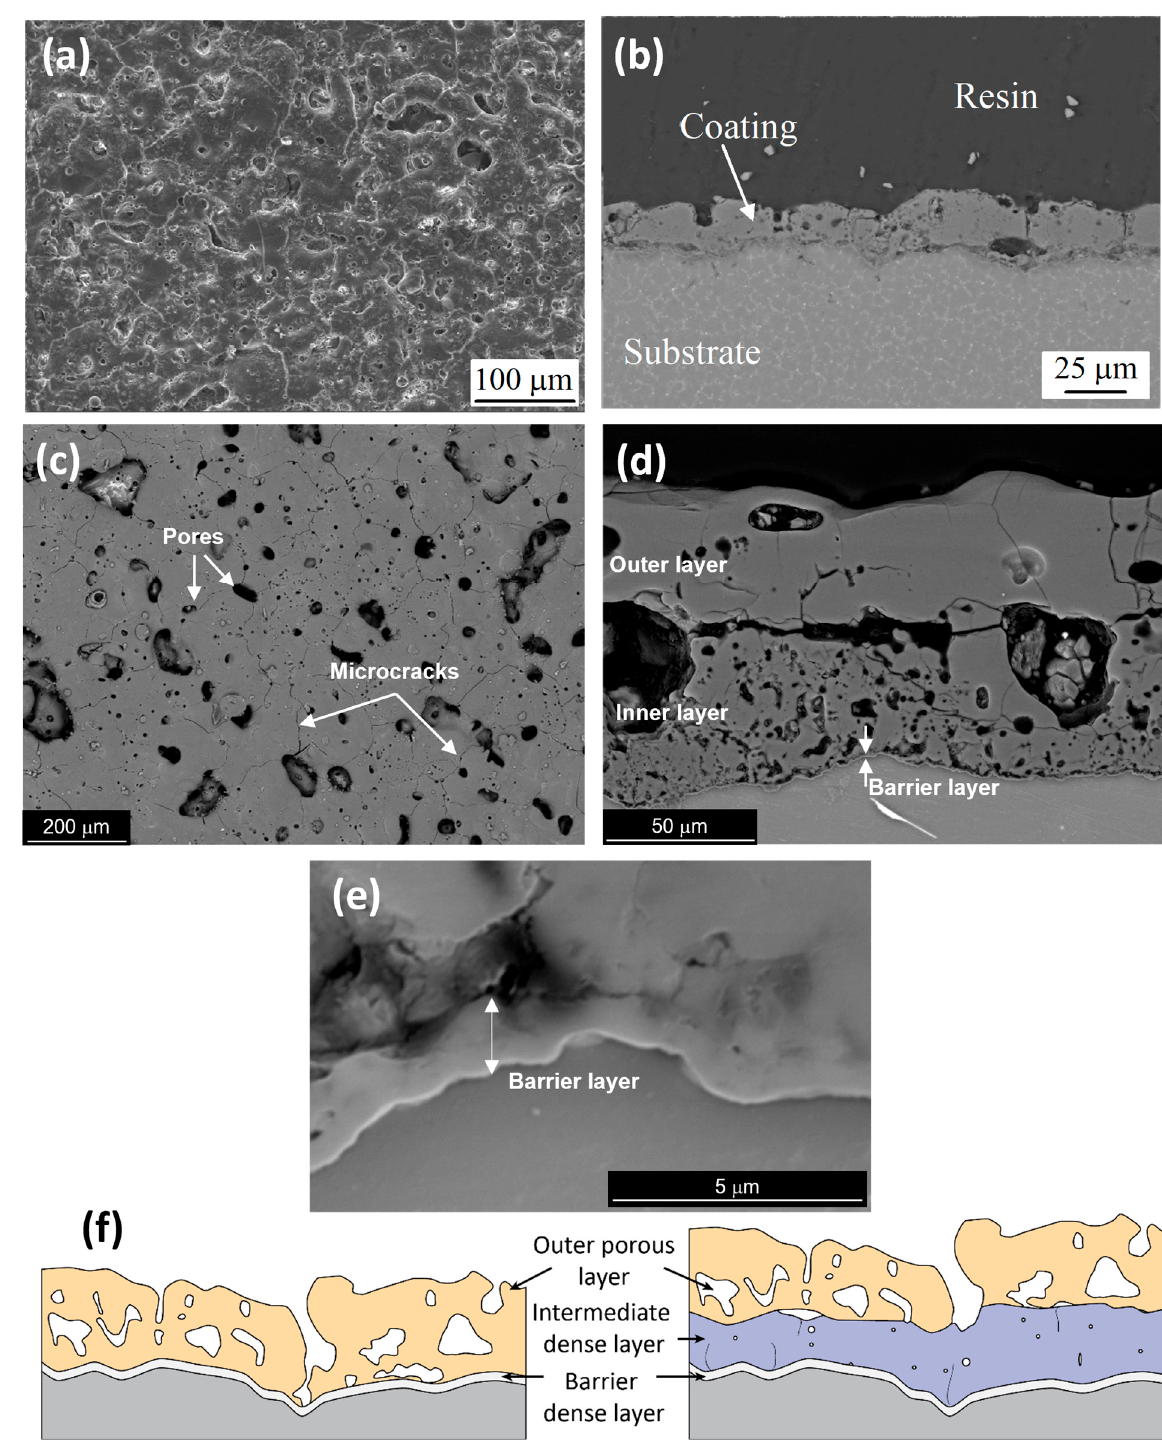
Figure 5. Scanning electron micrographs of two-layer ( a , b ) [49] and three-layer ( c – e ) [53] PEO coatings on Mg alloys. Schematic diagrams of two-layer and three-layer PEO coatings ( f ). ( a , b ) Reprinted from [49], ( c – e ) reprinted from [53] with permission from Elsevier.